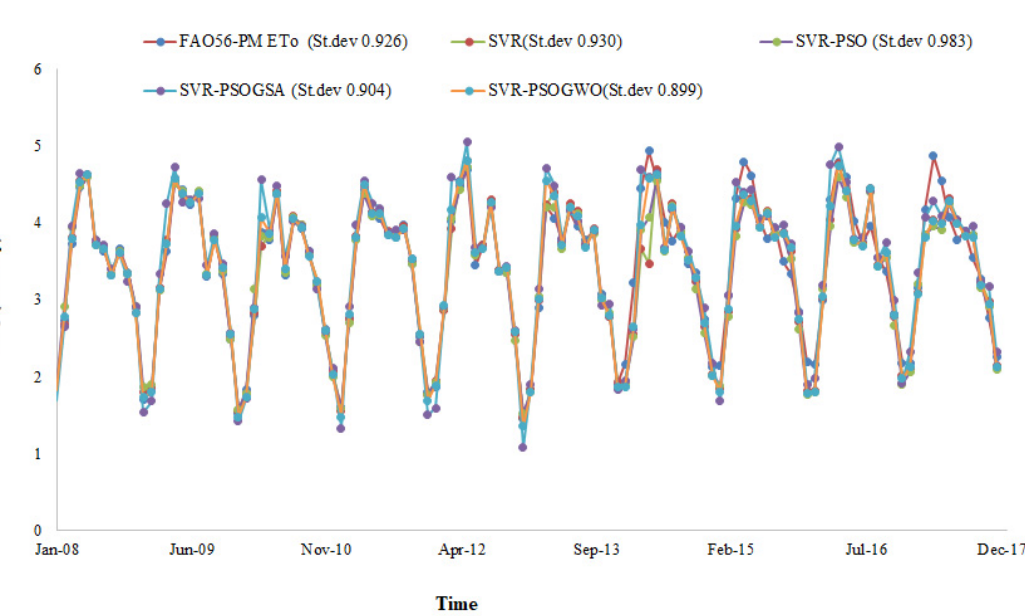
Figure 3. Time variation graphs of the FAO56 ‐ PM Eto and predicted ETo by different SVR ‐ based models in the test period of Bogra Station.